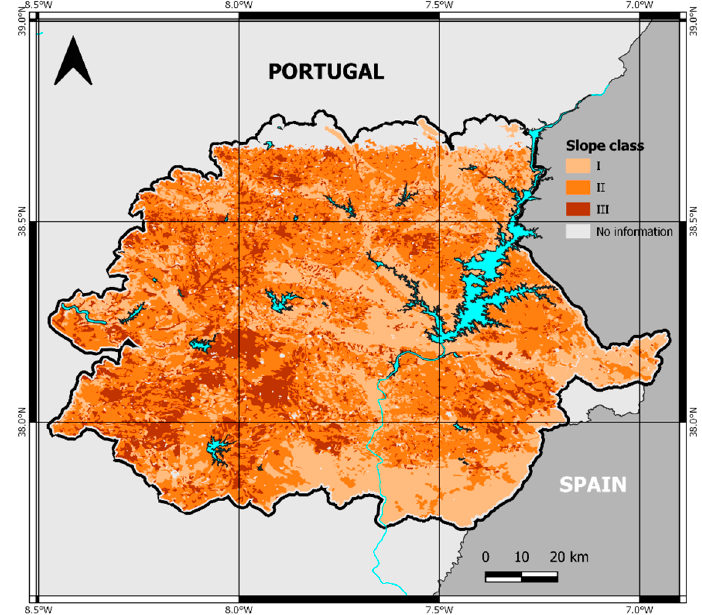
Figure 3. Slope classes of the study area. I—>9%; II—3% to 8%; III—0% to 2%.